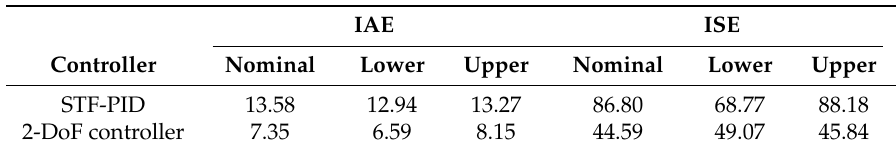
Table 4. The comparison of the integral error performance index. IAE, integral absolute error; ISE, integral squared error; STF, self-tuning fuzzy